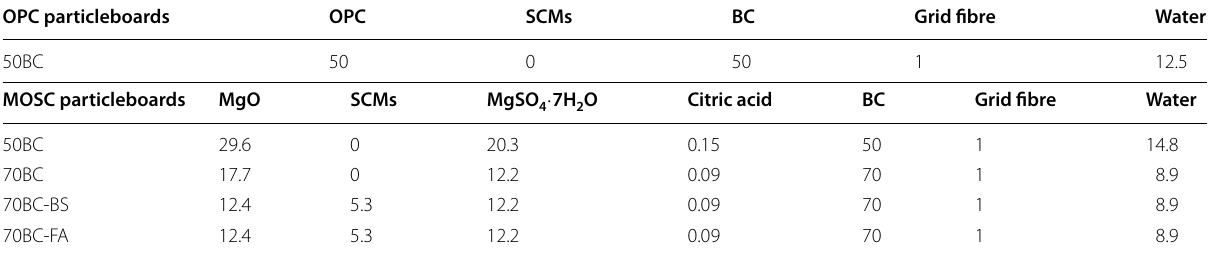
OPC: ordinary Portland cement; BC: saturated surface dry biochar; MOSC: magnesium oxysulfate cement; SCMs: supplementary cementitious materials